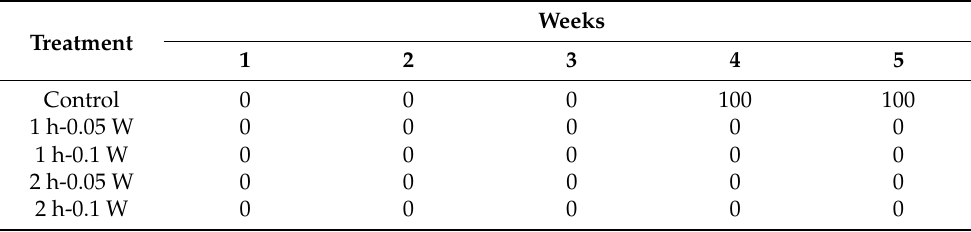
Figure 8. Appearance of a red perilla leaf at the 5th node counted from the bottom of the main stem 2 weeks after treatment initiation (Experiment 3). Perilla plants were irradiated for 1 or 2 h every 1 or 2 h for 6 h, from 18:00 to 6:00. The UV-B radiation intensity at the canopy level was set to 0.05 or 0.1 W m − 2 . Leaves at the 5th node counted from the bottom of the main stem were harvested 2 weeks after treatment initiation. Leaf blade length under treatment conditions of the control, and under conditions of exposure to 0.05 W m − 2 for 1 h, 0.1 W m − 2 for 1 h, 0.05 W m − 2 for 2 h, and 0.1 W m − 2 for 2 h was 11.3 ± 0.6, 10.2 ± 1.5, 8.4 ± 1.2, 10.5 ± 0.5, and 8.0 ± 0.7 cm, respectively (mean ± SE, n = 5). Each black bar indicates 5 cm. Table 3. Weekly percentage flowering of red perilla (Experiment 3, n = 5). The weekly percentage flowering was determined by dividing the number of plants that formed flower buds by the number of plants tested. Perilla plants were irradiated for 1 or 2 h every 1 or 2 h for 6 h, from 18:00 to 06:00. The UV-B radiation intensity at the canopy level was set to 0.05 or 0.1 W m − 2